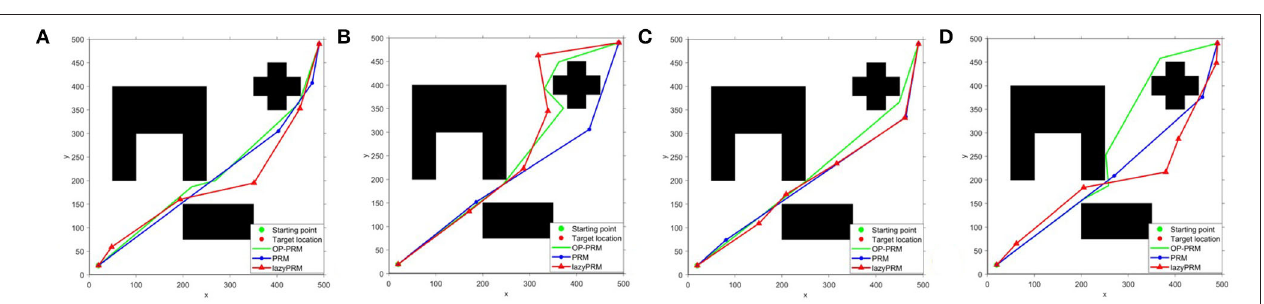
FIGURE 11 | (A–D) The performance comparison in environments with concave polygon